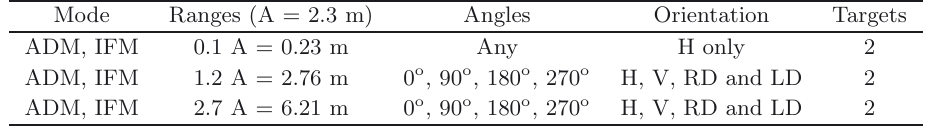
Table 1. Main B89.4.19 volumetric test configurations.